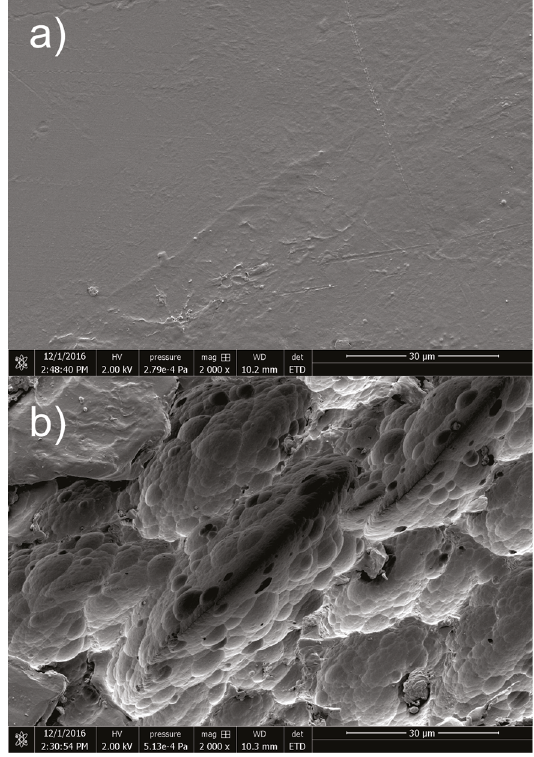
Figure 11. SEM of the PET sample (a) before and (b) after chemical attack with NaOH for 30